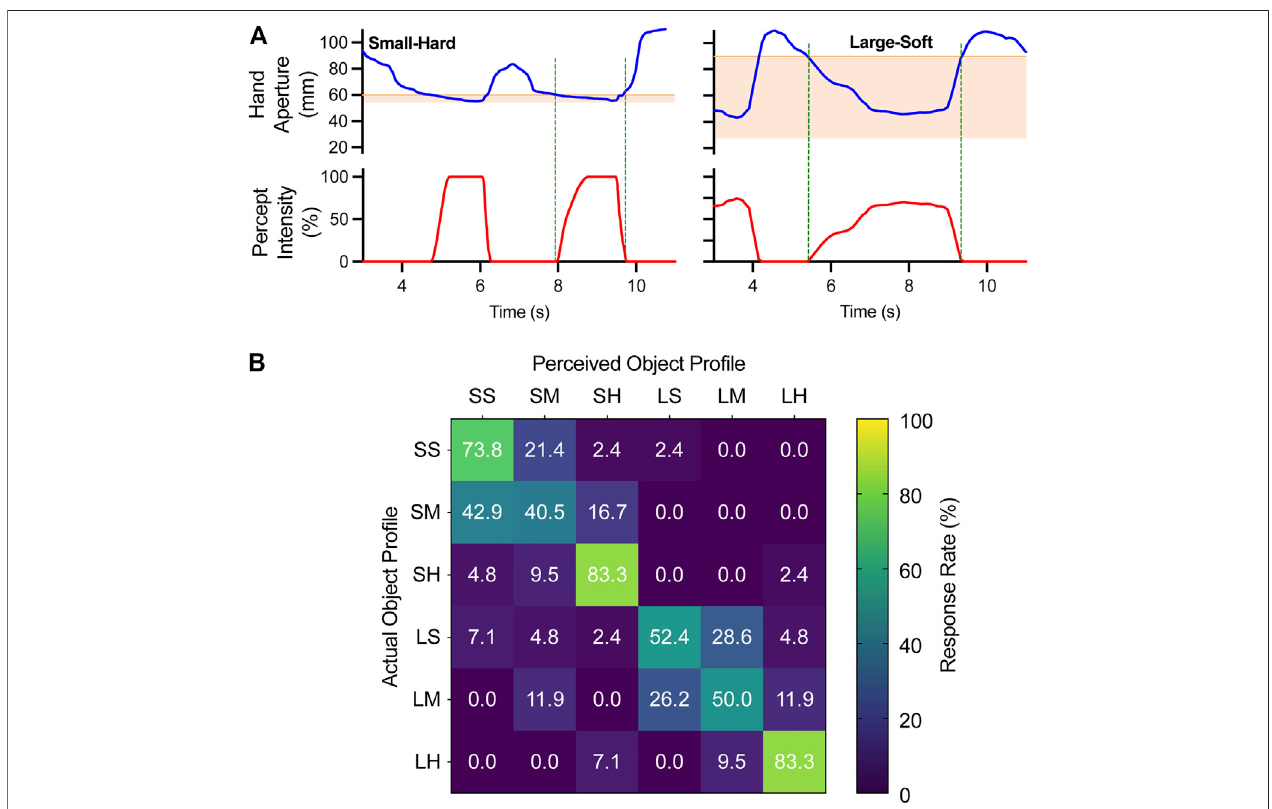
FIGURE6| Feedback ofgraspforcepro fi lesenablesidenti fi cationofvirtualobjectsizeand compliance. (A) Exampleofhandaperture(blue)and virtualgraspforce pro fi le (red) traces when grasping a Small-Hard object (left) and a Large-Soft object (right). The shaded regions represent the compressive range of the object. (B) Confusion matrix quantifying the perceived size and compliance combined (left-right), in relation with the presented pro fi le (up-down) across 36 trials per participant. Each blockrepresentsthefrequencyofresponsesprovidedbyallparticipantswhentheywerepresentedwithapro fi le(actual)andclassi fi edit(perceived).The fi rst letter indicates the size (small/large) and the second letter indicates the compliance (soft/medium/hard). Successful identi fi cation of both size and compliance (diagonal) by chance is 16.7%.